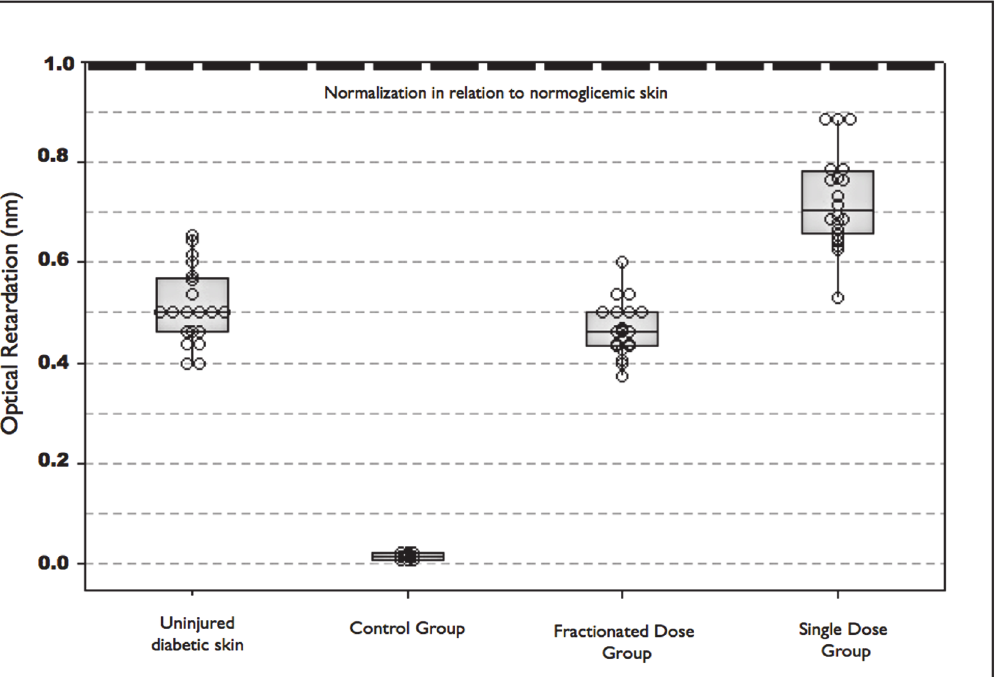
Fig 8. Optical retardation analysis of collagen on Day 22, showing most organized collagen in SDG, followed by uninjured skin, FDG and